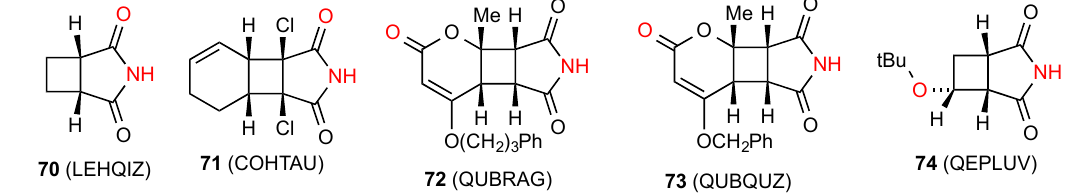
Figure 25. Cyclobutane-fused succinimides showing common bonding patterns.